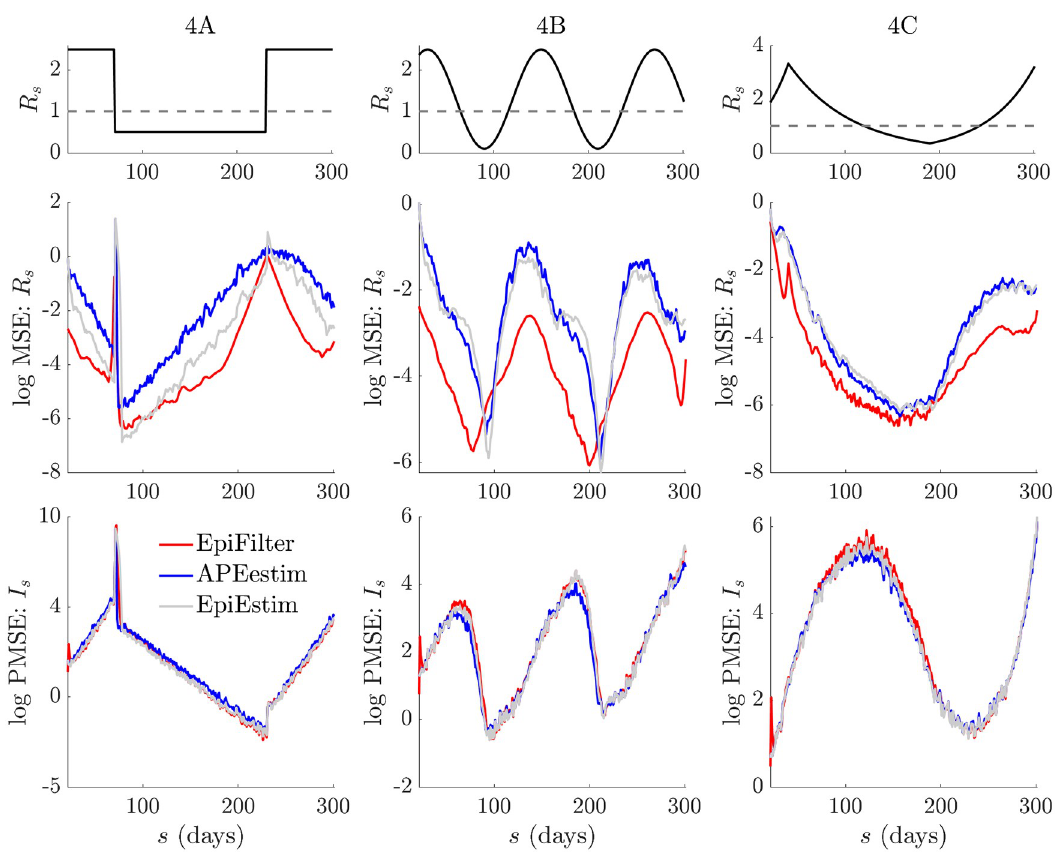
Fig 5. Temporal statistics of epidemics with multiple waves. We expand on the results from Fig 4D by decomposing the MSE and one-step-ahead PMSE statistics across the 200 simulated trajectories for every scenario in Fig 4. We do not consider the k = 31 EpiEstim example given its poor performance. We present the k = 7 case, which is the generally recommended EpiEstim setting. We observe that EpiFilter significantly improves on MSE throughout the resurgent epidemic trajectory (whether incidence is small or large) while maintaining comparable prediction accuracies. Coverage statistics for these scenarios, which are given in Fig D of the S1 Appendix, confirm that EpiFilter consistently contains the true R and I values within its credible s s